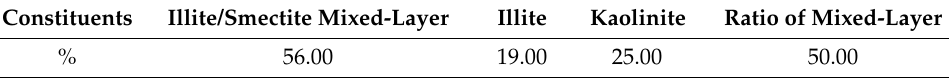
Table 3. Mineral components of the